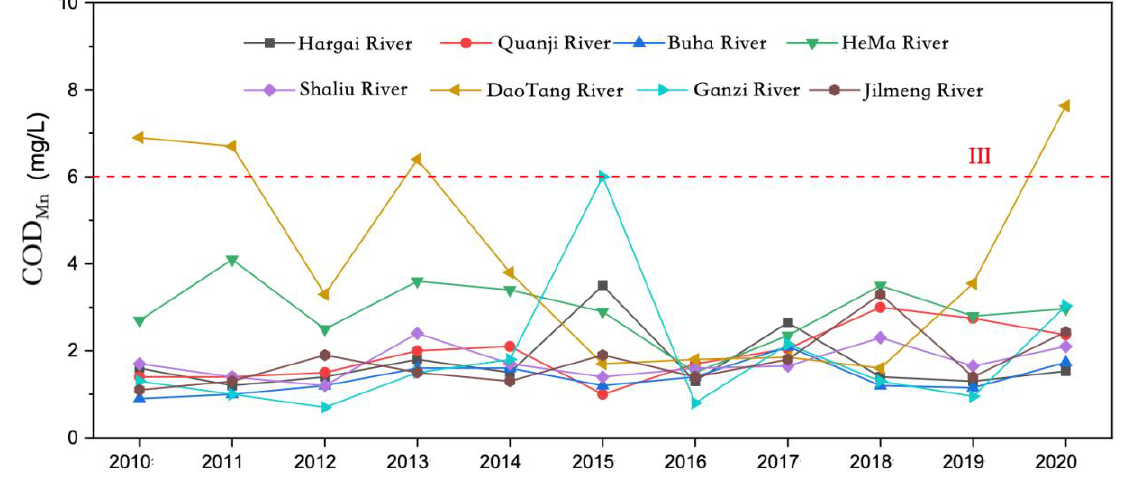
Figure 8. Change trend of the permanganate index of rivers entering the lake from 2010 to 2020.